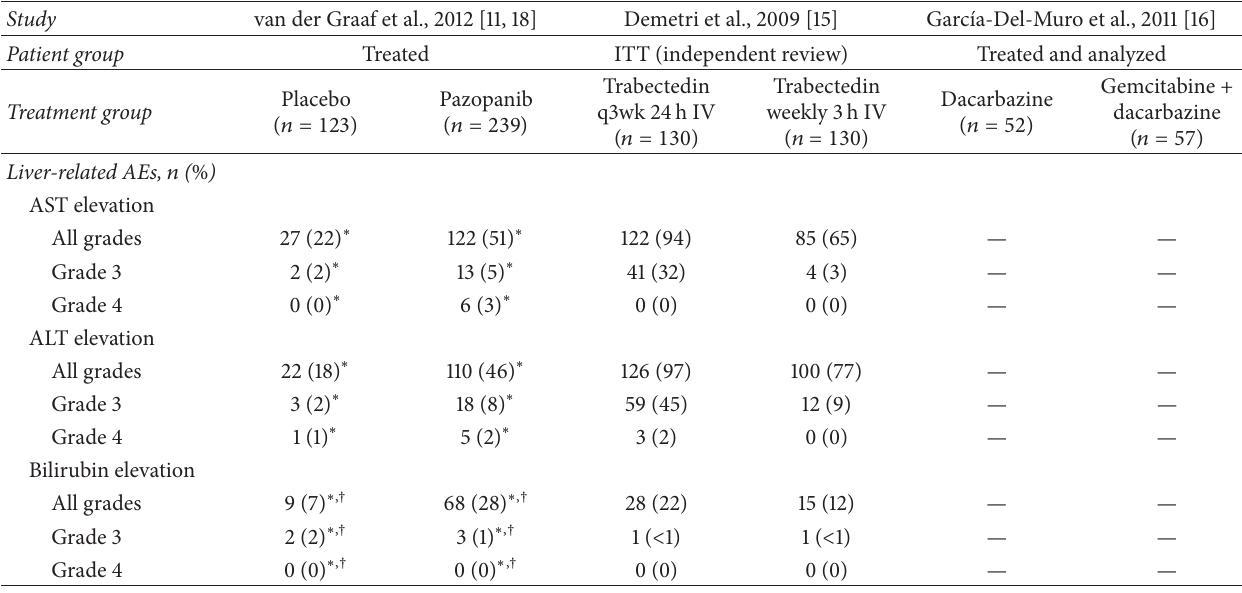
Table 2: Patients experiencing selected liver-related